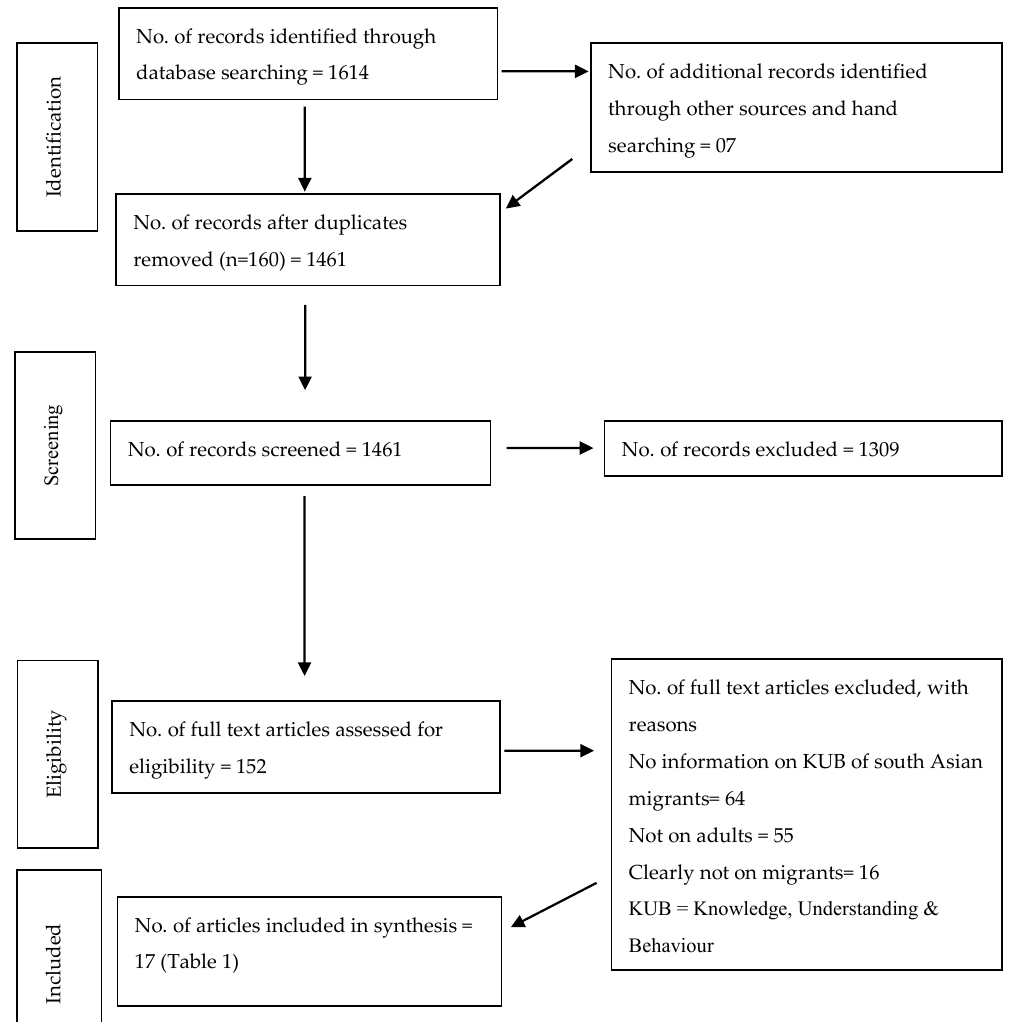
Figure 1. Preferred reporting items for systematic reviews and meta-analysis (PRISMA) flow chart of the study selection process [17].